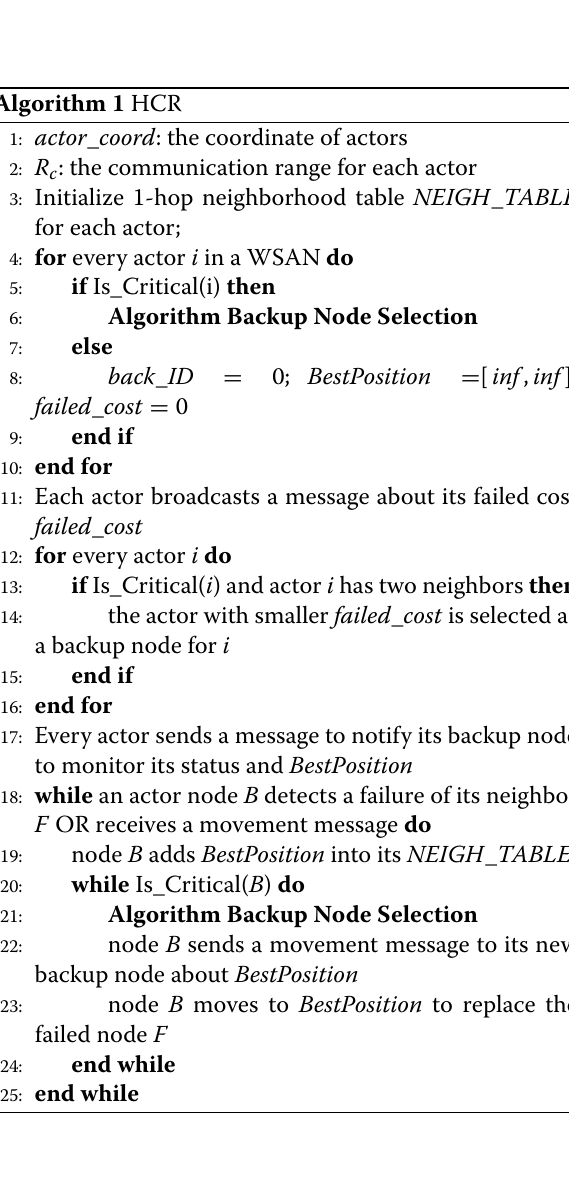
Algorithm Backup Node Selection